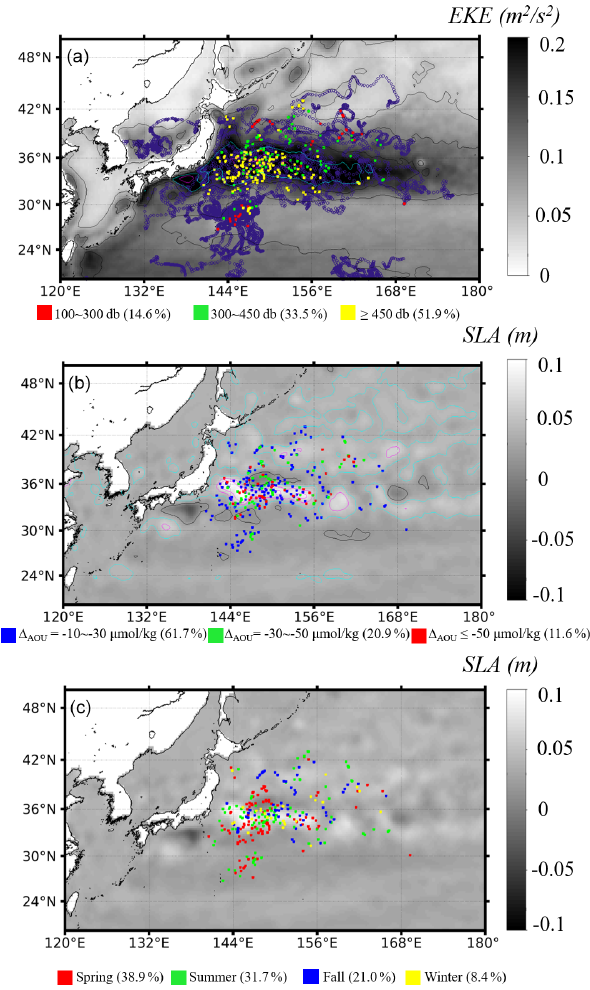
Figure 5. Horizontal distribution of the BGC-Argo data profiles as- sociated with subduction patches (a, b) between 2008 and 2019 in the western North Pacific. The profiles with detected subduction patches are color-coded by different intervals of depths of the sub- duction patches (a) , AOU anomalies (b) , and seasons (c) , with per- centages of detected patches in each interval annotated. The purple background data in (a) represent all the analyzed profiles as shown in Fig. 2a. The greyscale background map in (a) is the annual mean EKE climatology, with EKE contour lines of 0.3, 0.2, and 0.1m 2 /s 2 shown in magenta, cyan, and black, respectively, and the greyscale background map in (b) is the annual mean SLA climatology, with SLA contour lines of ≥ 0 . 06, 0.04, and 0.02m shown in magenta, cyan, and black, respectively. The seasons in (c) are divided into the